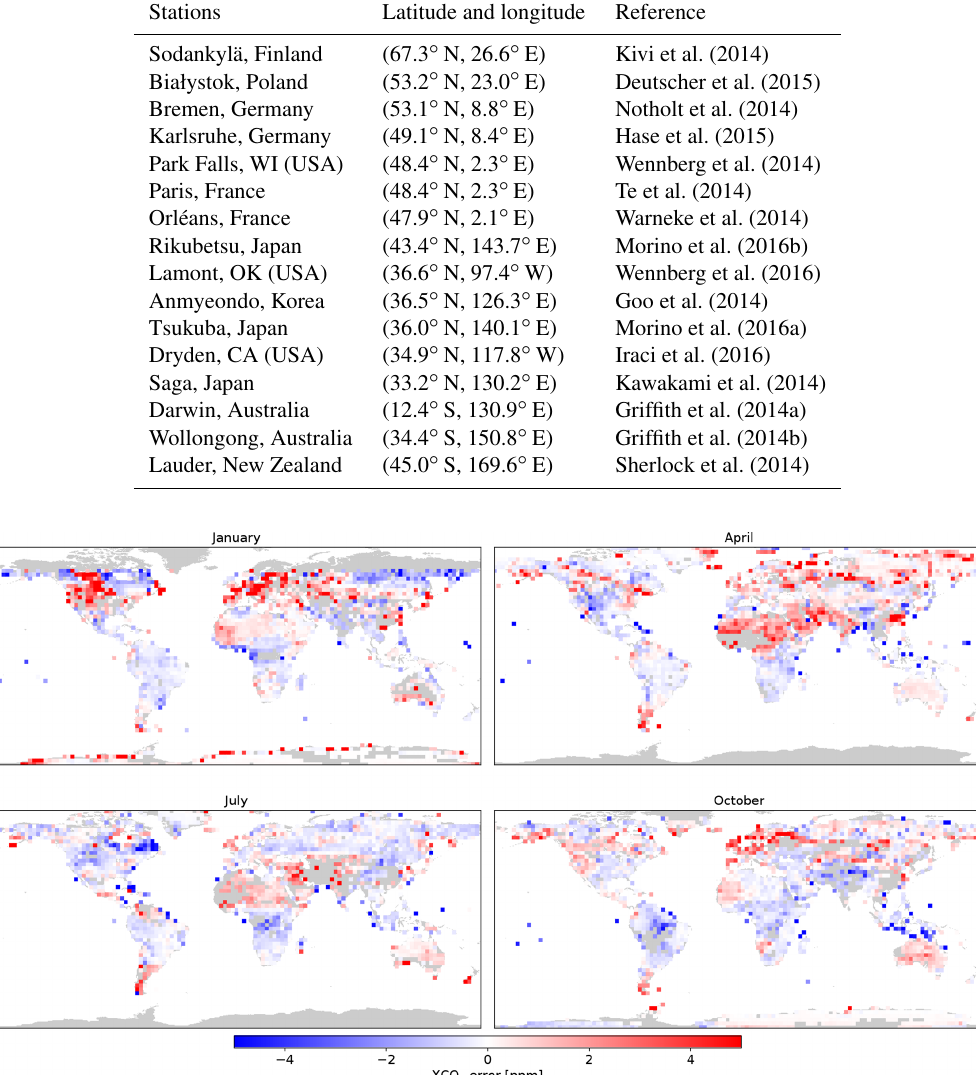
Figure 2. XCO 2 retrieval errors from MSR-d synthetic spectra of the test 1 for the global ensemble of Butz et al. (2009). Gray areas over land are not processed or retrievals do not